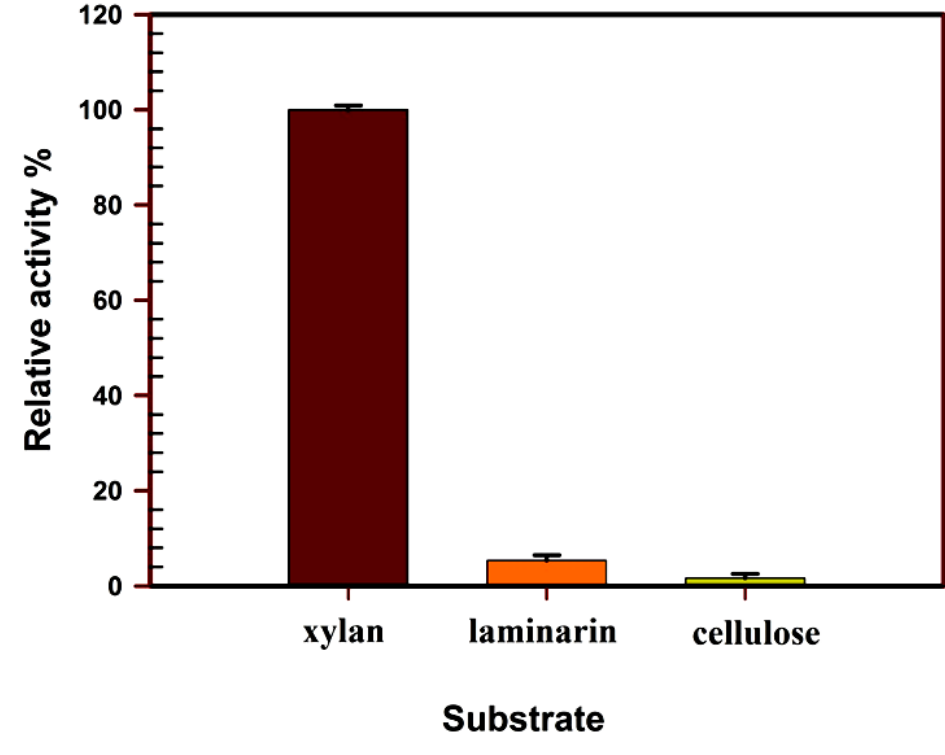
Figure 7. Substrate specificity of purified xylanase.